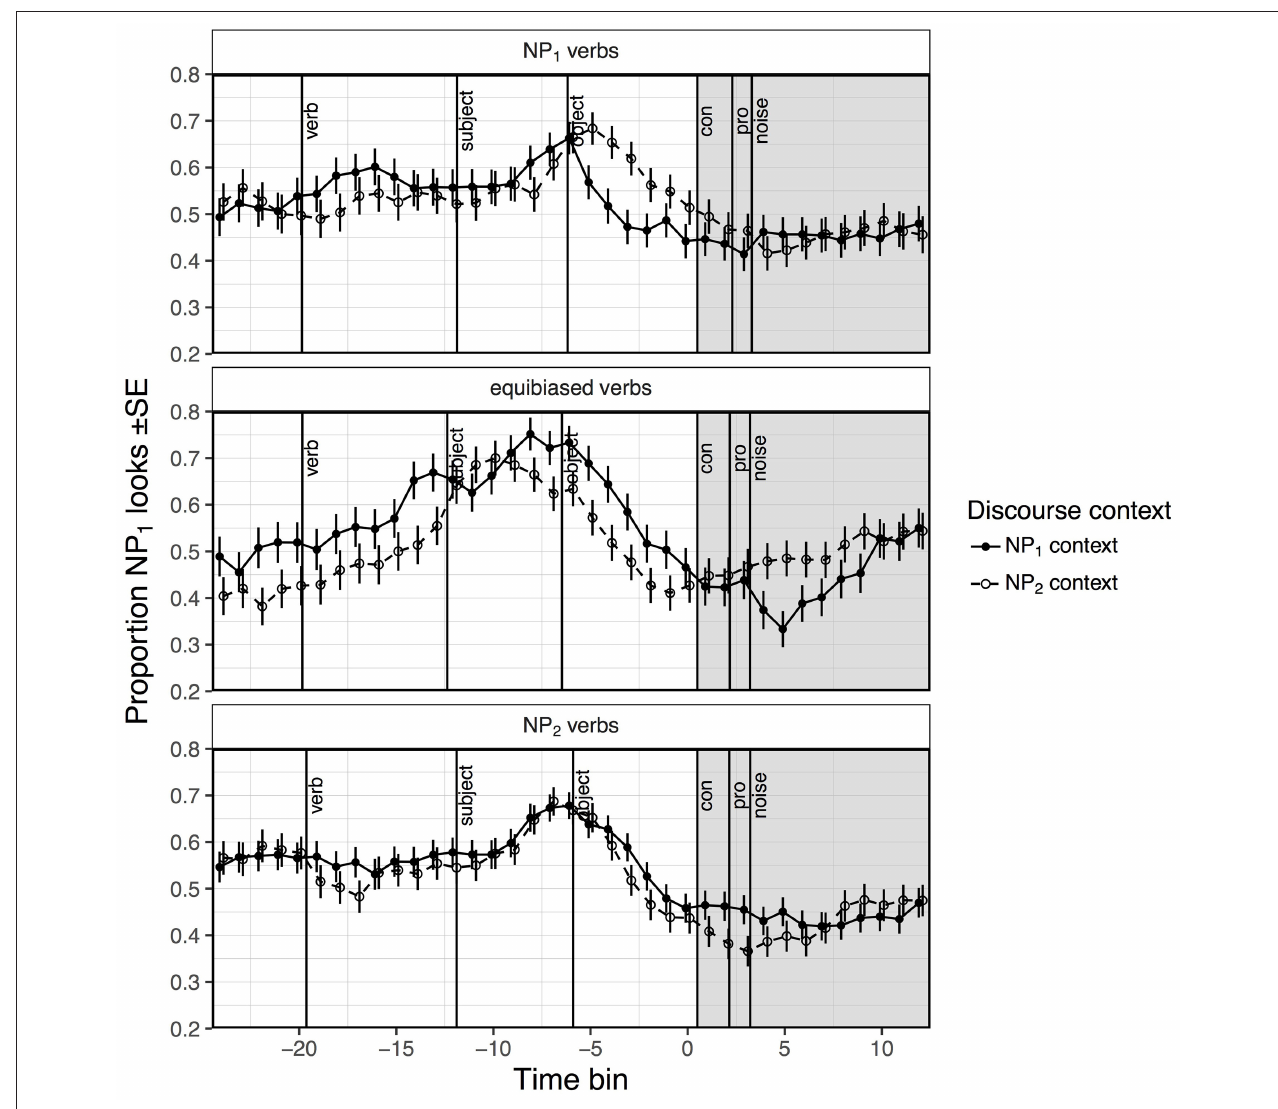
FIGURE 4 | The proportion of looks toward the NP 1 character out of looks toward the NP 1 and NP 2 characters per time bin in Experiment 2, by IC Bias and Discourse Context. The time window shows looks from 2500ms before the onset of the connective until the onset of disambiguating information. Each time bin represents 100ms. Vertical lines indicate the mean onset of the verb, subject, object, ambiguous pronoun (pro), and filler region per IC bias bin, and the onset of the connective (con), to which the data were time-locked. The shaded area indicates the region that was included in the statistical